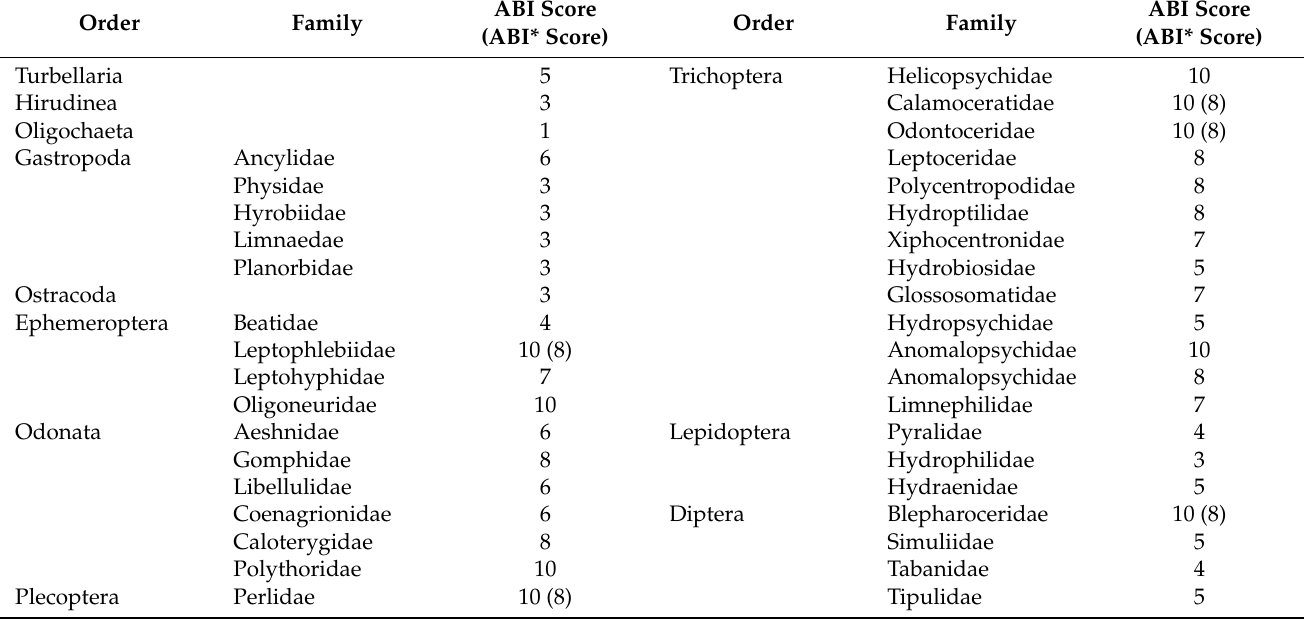
Table 4. Family and Order of Benthic Macroinvertebrates considered in the ABI; also listed are the quantified values of the pollutant sensitivity (ABI score) [20]. Between parenthesis are the ABI*